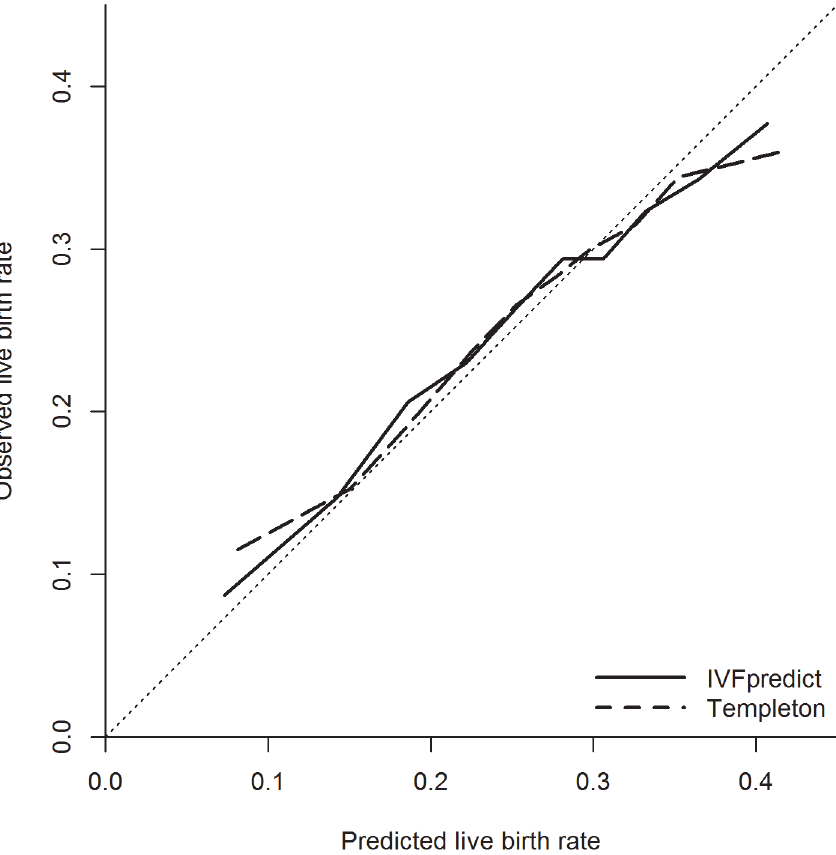
Fig 3. Calibration plot for updated IVFpredict and Templeton models. Based on 130,960 IVF cycles. Hosmer-Lemeshow test statistics: p < 0.001. Solid line, updated IVFpredict model; dashed line, updated Templeton model; dotted, diagonal line, perfect prediction (reference).